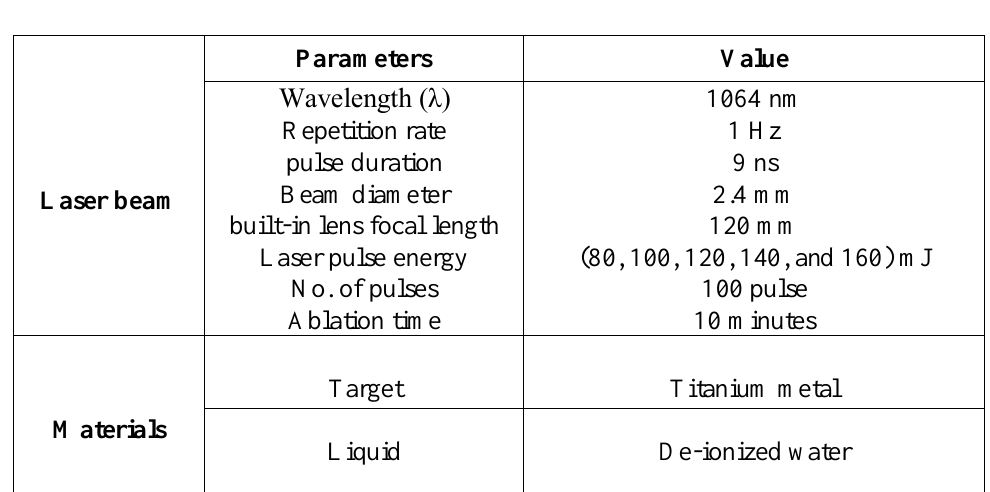
Table 1: Laser beam parameters used in preparation of TiO 2